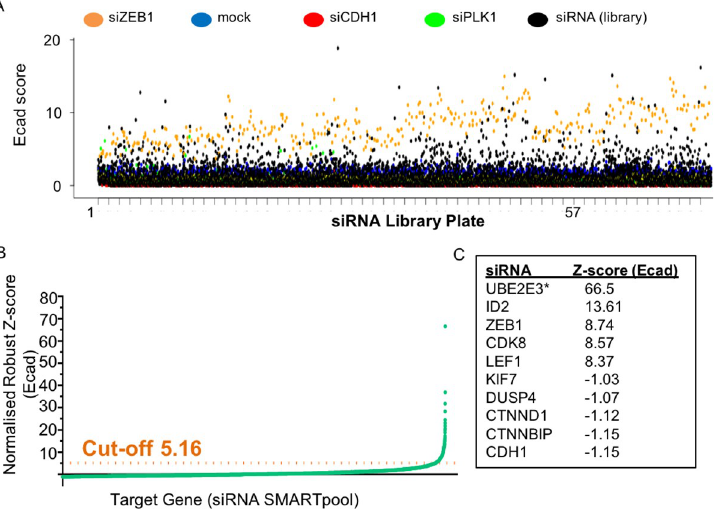
Fig 2. A genome-wide imaging based siRNA screen identifies regulators of membrane-associated E-cadherin in SW480 colon cancer cells. (A) Membrane associated Ecad scores normalised to mock transfectants for all SMARTpool siRNAs (black) transfected into SW480 cells. Controls are highlighted: mock (blue), si ZEB1 (orange), si CDH1 (red) & si PLK1 (green). (B) Mock normalised Robust Z-score (Ecad) plot for SMARTpool siRNA screen. The cut-off for E-cadherin negative regulatory genes is indicated by the red-dotted line (Z-score > 5.16); the Z- score cut-off for positive regulatory genes is < 0.036. (C) Normalised Robust Z-score (Ecad) (Z-score Ecad) is shown for genes with a functional association with E-cadherin regulation and a gene � with potential miRNA-200 family off-target effects.